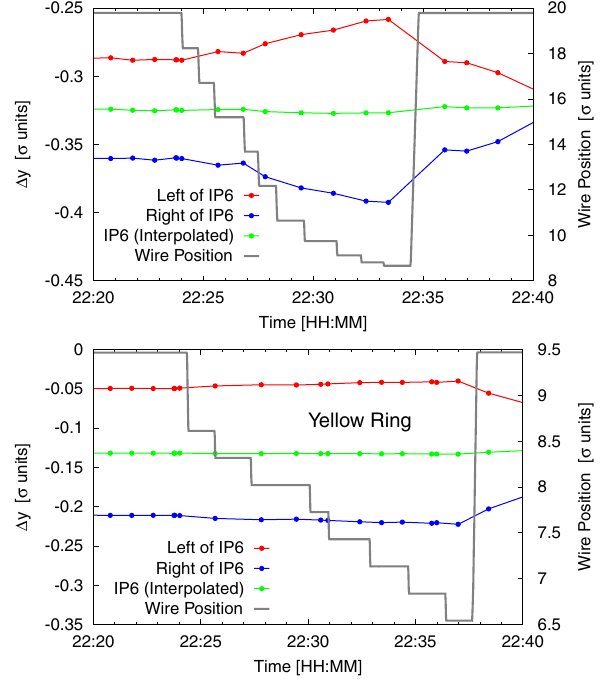
FIG. 16. Orbit offset at IP6 as a function of the wire position for Blue (top) and Yellow (bottom) rings with a current of 50 A.